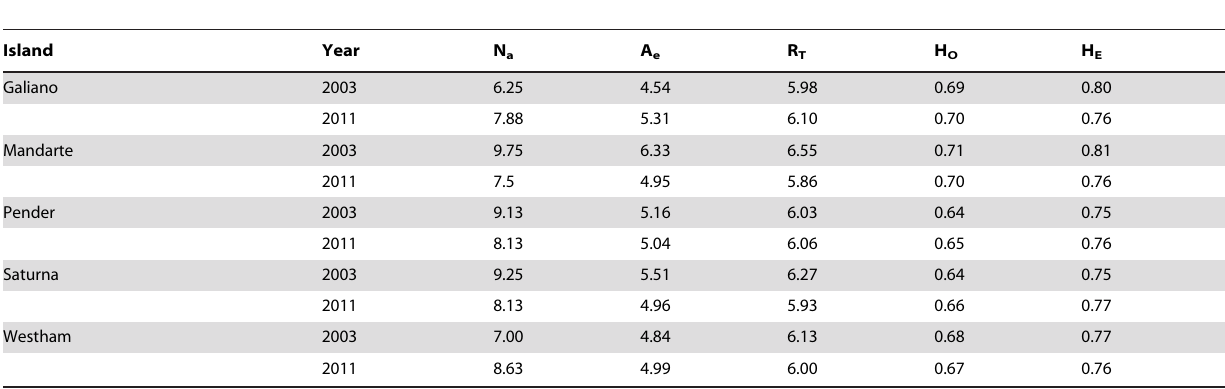
Table 2. Genetic diversity estimates for Malacosoma californicum pluviale populations from five islands in British Columbia, Canada.